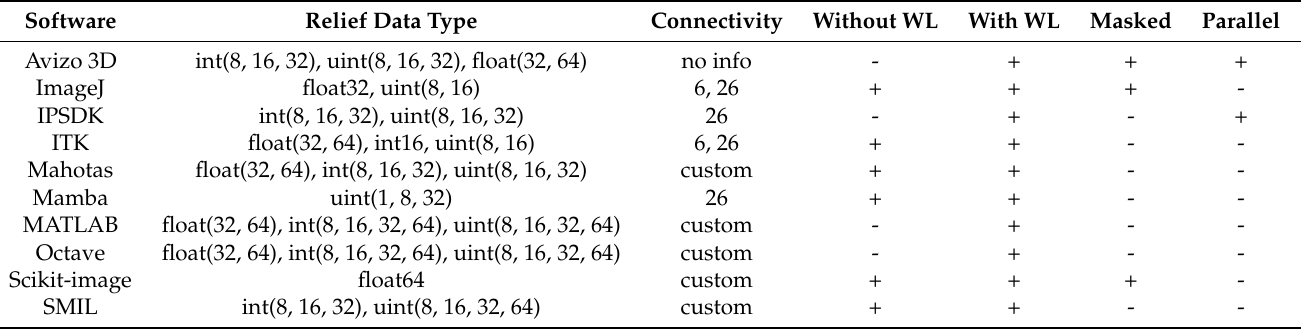
Figure 3. Segmentation outcome for relief from Figure 2b: ( a ) float32 data, ( b ) int16 data. Table 2. Features of the considered implementations of watershed for 3D